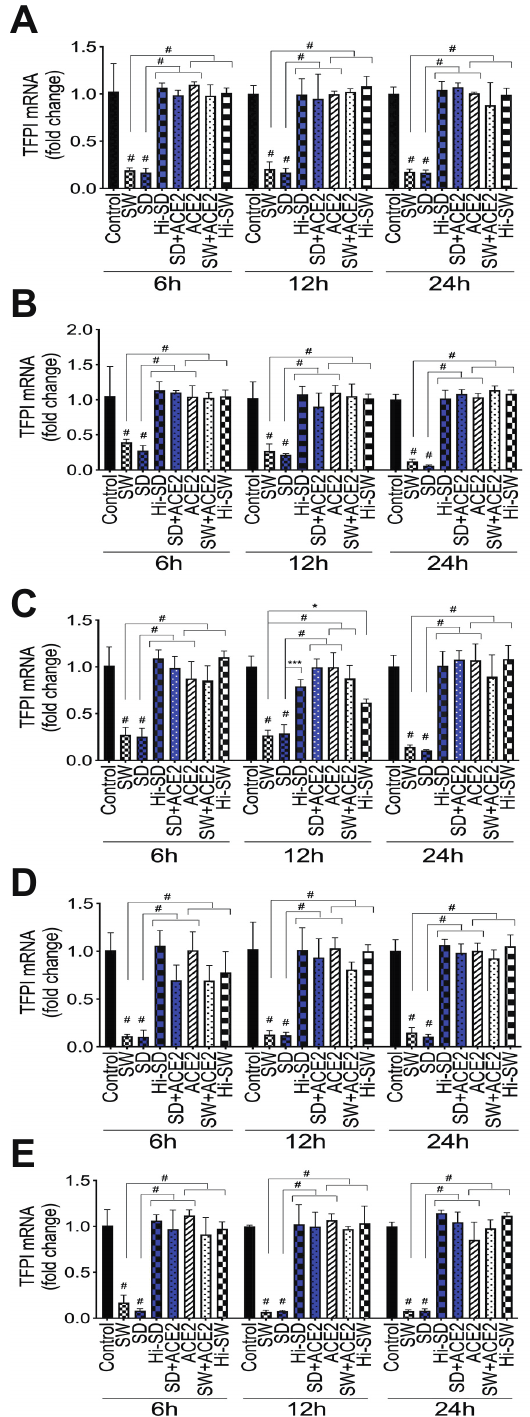
Figure 6. S-proteins and endothelial–neutrophil interactions inhibit TFPI transcription in HLMEC and neutrophils. ( A ) HLMEC treated with S-proteins (1 nM SW or SD) for 6–24 h; ( B , C ) HLMEC treated 6 h with S-proteins, washed, and co-cultured with neutrophils for 6–24 h; ( D , E ) Human neutrophils treated 6 h with S-proteins, washed, and co-cultured with HLMEC for 6–24 h. Following treatment, each cell type was harvested separately and TFPI mRNA levels in endothelial cells ( A , B , D ) and neutrophils ( C , E ) were quantified by real-time PCR. Data presented as mean ± standard deviation. Control: untreated cells; ACE2: cells treated with rhACE2 (1 µ g/mL); Hi: cells treated with heat-inactivated S-proteins. * p = 0.025; *** p = 0.0002; # p <